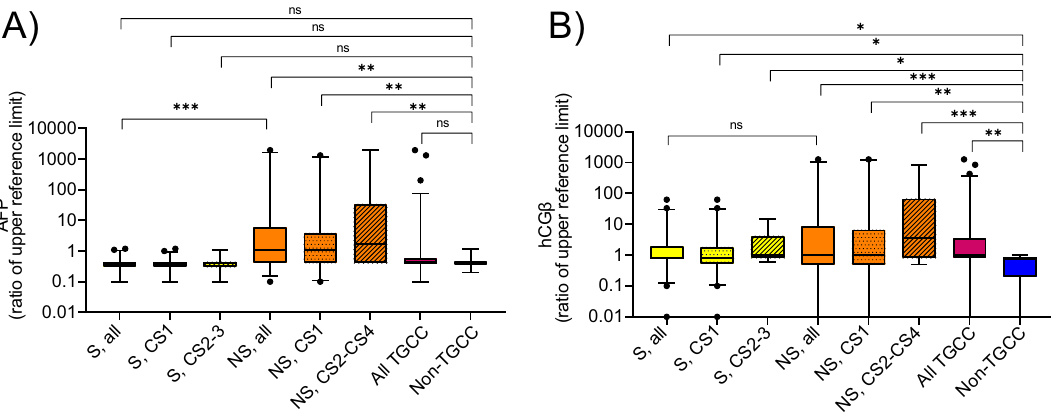
Figure 4. Expression of AFP and hCGβ across the histological sub-types and clinical stages. Shown are mean values with 95% confidence interval. S seminomas, NS non-seminomas, TGCC testicular germ cell cancer, TGCCC patients included with suspected TGCC, but diagnosed with other benign and malignant conditions; Healthy males, blood donors. *** P < 0.001; ** P < 0.01; * P < 0.05, ns P >